Question: What form of chart is displayed?
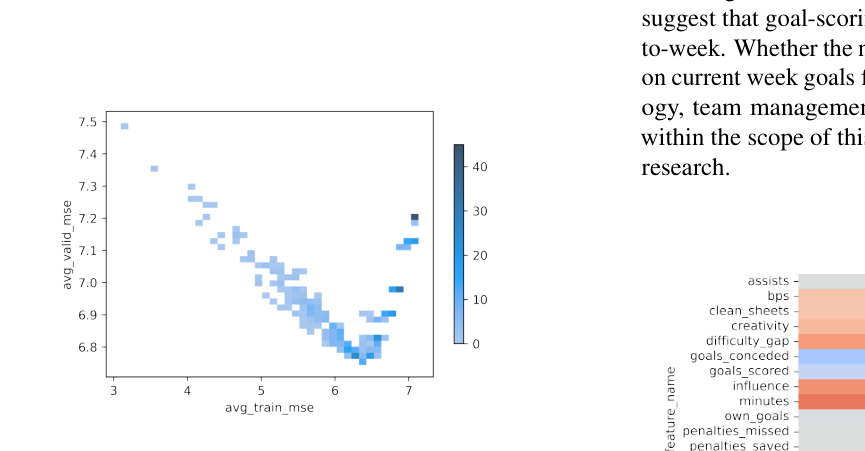
Answer: histogram